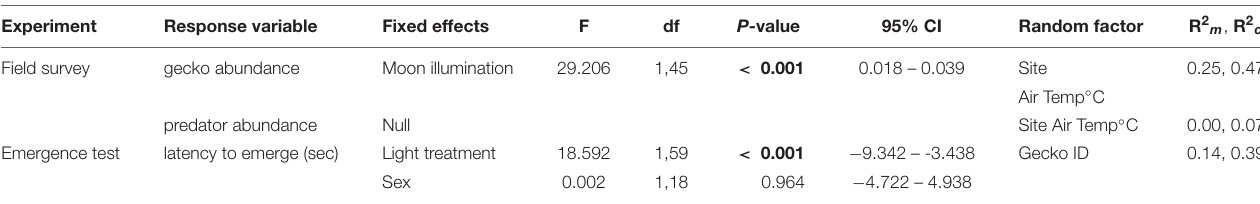
TABLE 2 | Top models for linear mixed-effects results examining the effect of (adjusted) moon illuminations on (adjusted) gecko abundance during field surveys, and the effect of light treatment and species on latency to emerge from a shelter tile. Bold P -values indicate statistical significance.